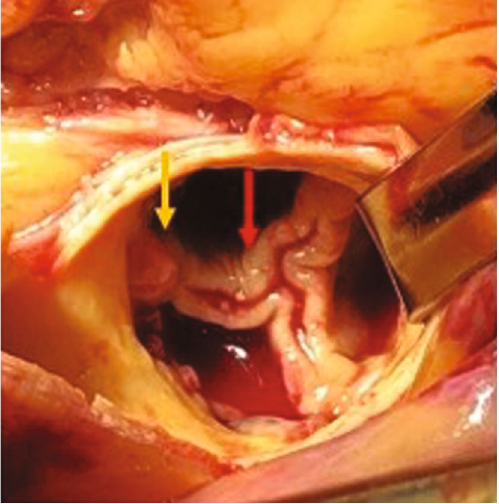
Figure 3: 3D transesophageal echocardiography of infected TAVR showing bulky vegetation on the anterior mitral valve lea fl et (arrow).